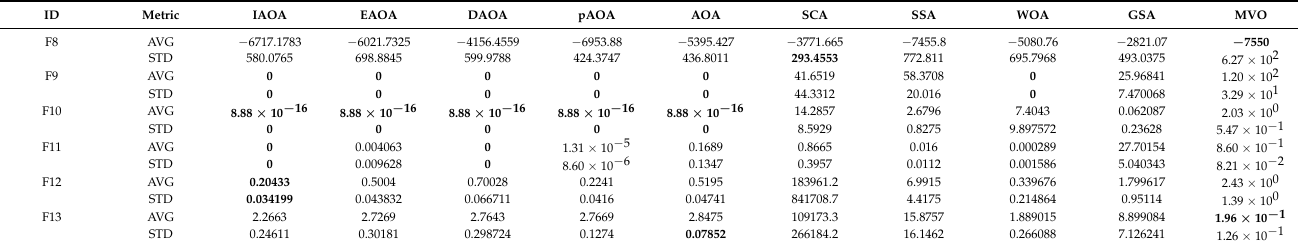
Table 2. Results of the multipeak function test with 30